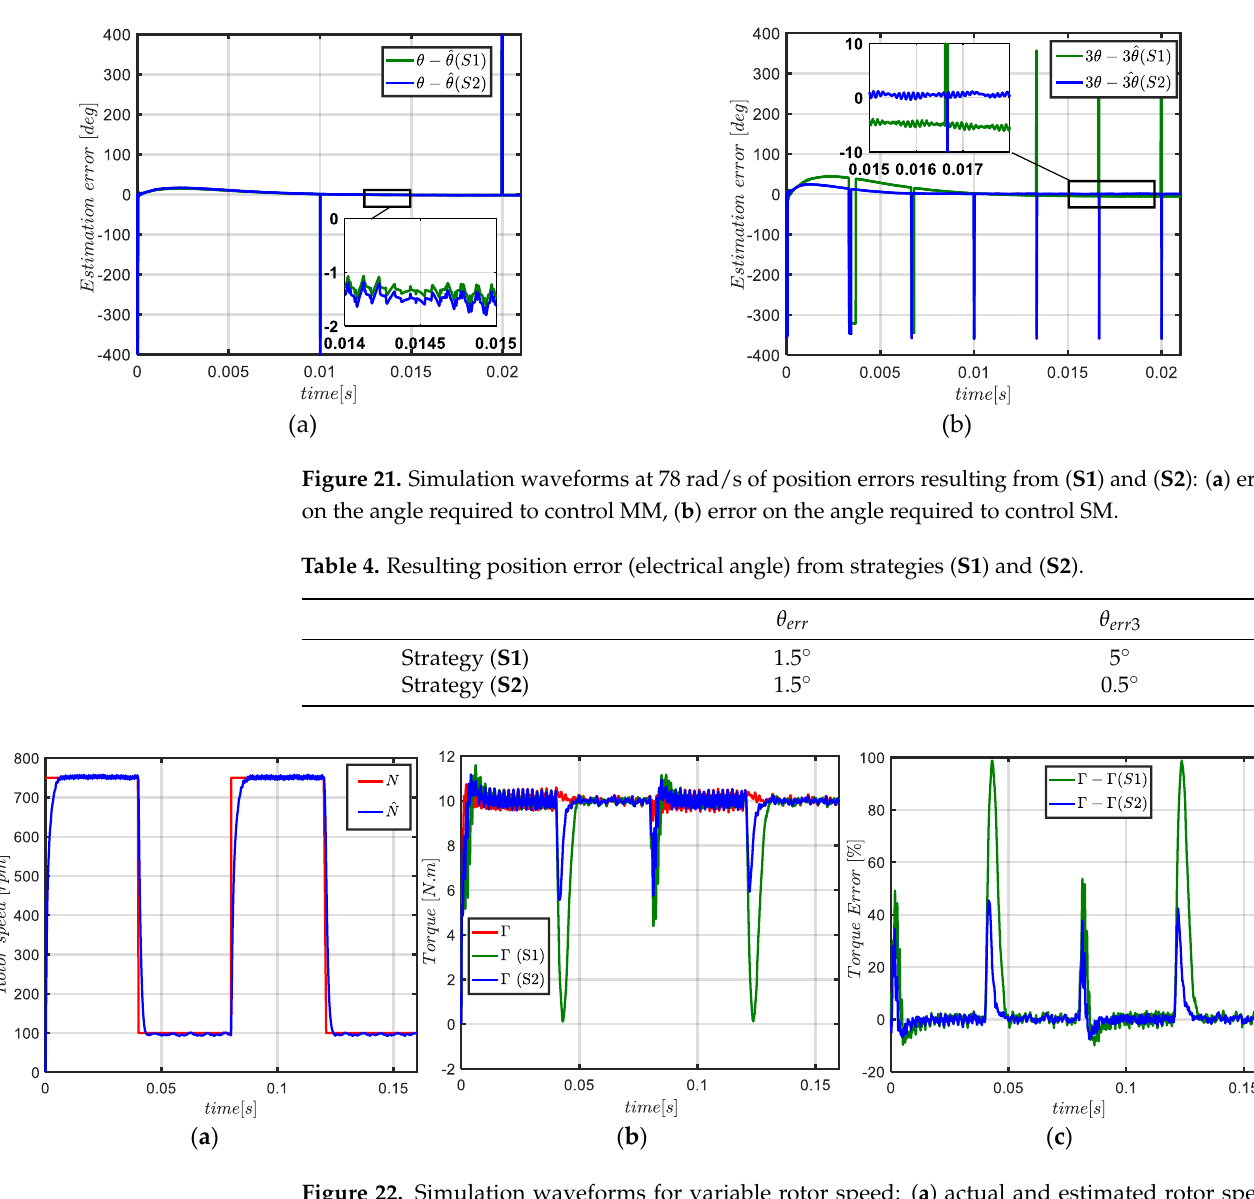
Table 4. Resulting position error (electrical angle) from strategies ( S1 ) and ( S2 ) .